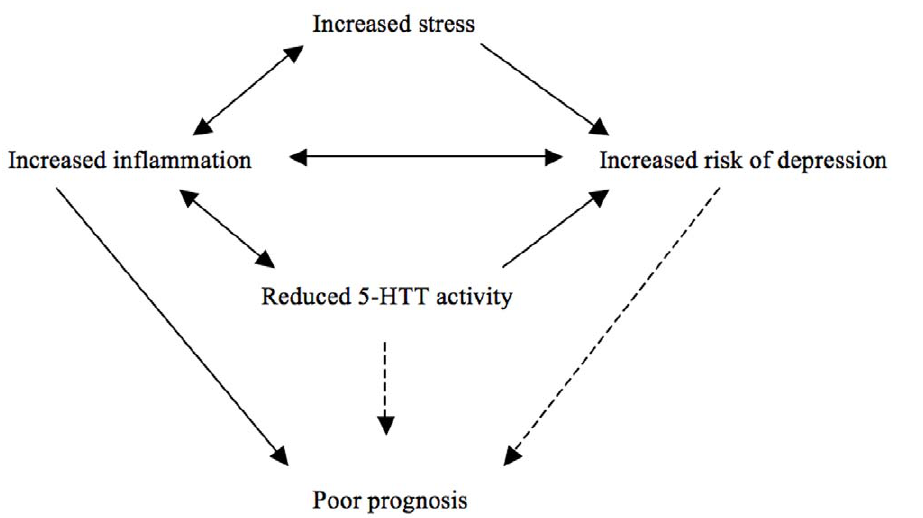
Figure 3. The 5-HTT activity may be altered as a response to changing cellular environment (such as inflammation) or by the genetic variations in the SLC6A4 gene. The direct links between the altered 5-HTT activity as well as the depression and prognosis in colorectal cancer patients (arrows with broken lines) remain to be established by further studies.